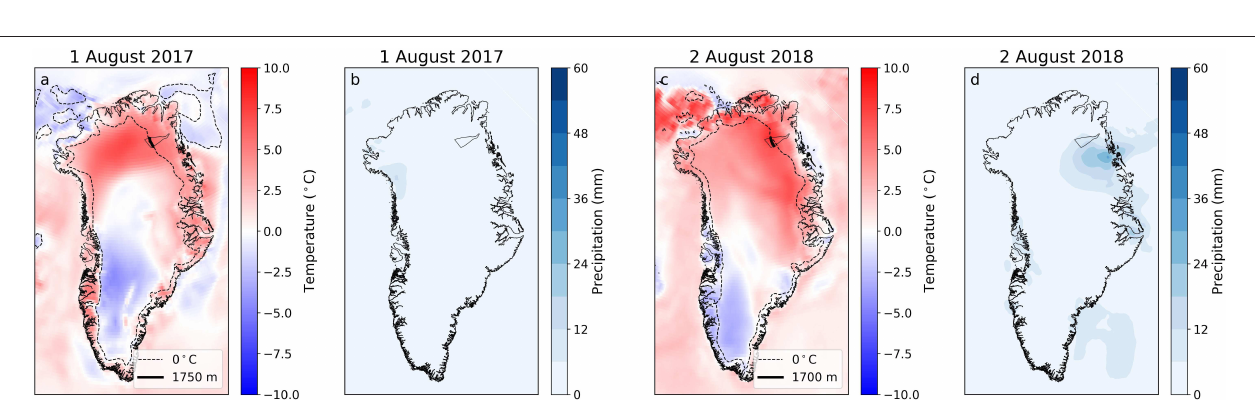
FIGURE 4 | Rapid drainage event (< 24 h) of lake 11 in September 2017. Sentinel-2 acquisition on 17 August 2017 at 15:09 is shown in (a) , lake is mostly ice free, yellow dot marks the location of lake depth measurement on 21 July 2017 ( Figure S2 ). Sentinel-2 acquisition on 18 September 2017 at 15:49 is shown in (b) , lake is completely covered by lake ice. Additional pre-drainage shorelines are shown. Note the difference in illumination between August and September. Sentinel-2 acquisition on 19 September 2017 at 15:18 is shown in (c) , the lake has drained and is not covered by ice anymore. TanDEM-X derived surface elevation changes between 13 and 24 September 2017 are shown in (d) .